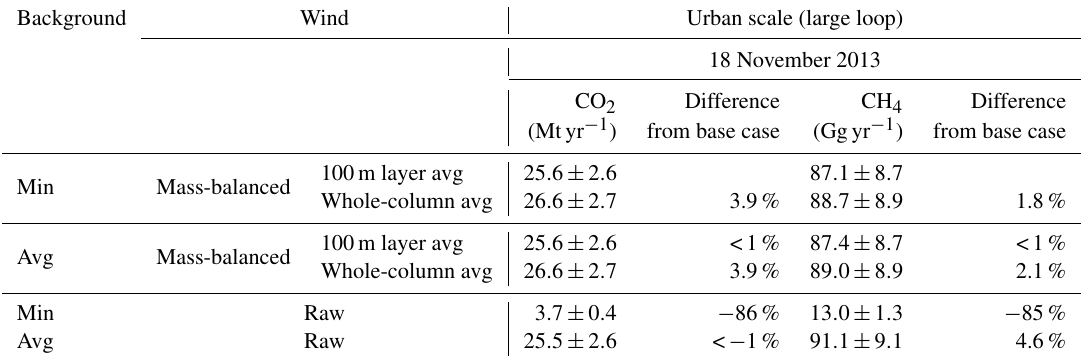
Figure 4. (a) Map of AJAX flight tracks colored by CH 4 mixing ratio for 18 November 2013, plotted in Google ™ Earth. (b) The data (red) fitted to an oval (green). The observed CH 4 mixing ratios (c) are kriged to generate the cylindrical surface (d) . The axes of the oval are approximately 25 and 40km. The yellow arrow represents the dominant wind direction. Table 1. Urban-scale CO 2 and CH 4 fluxes over Sacramento using different wind treatment (raw wind: “raw”, or mass-balanced wind: “mass- balanced”) and different background values (minimum or average values) on 18 November 2013. The vertical mass transfer (entrainment and surface flux) is included in these calculations. “Whole-column avg” means the vertical column average up to the estimated PBLH.